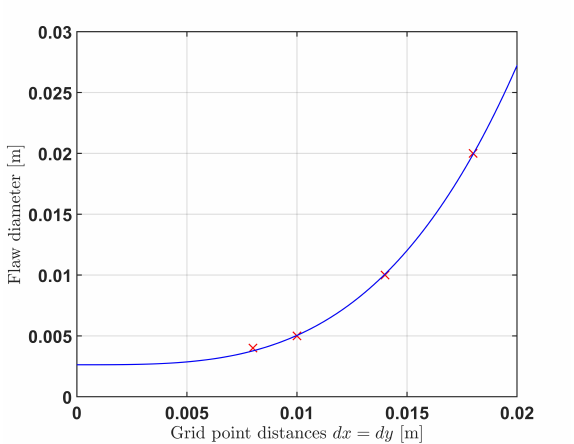
Figure 18. Determinable flaw size in relation to the grid point